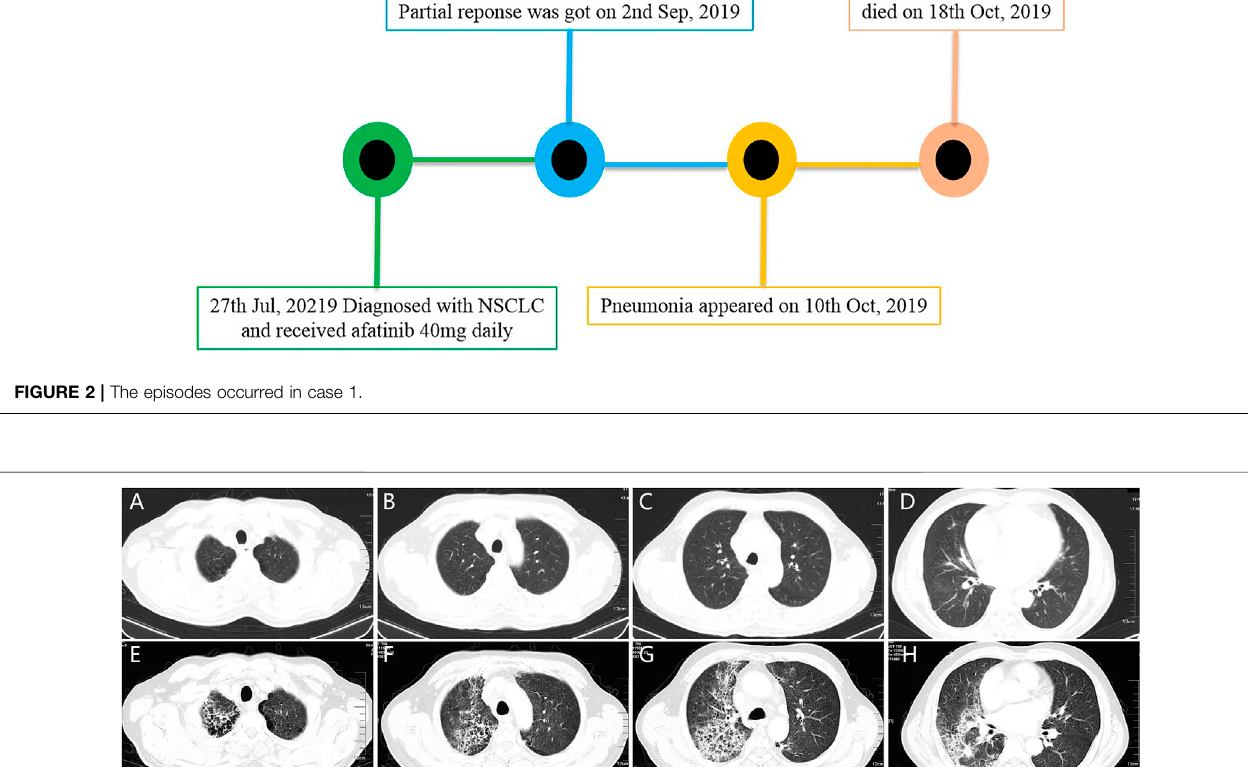
Frontiers in Pharmacology |